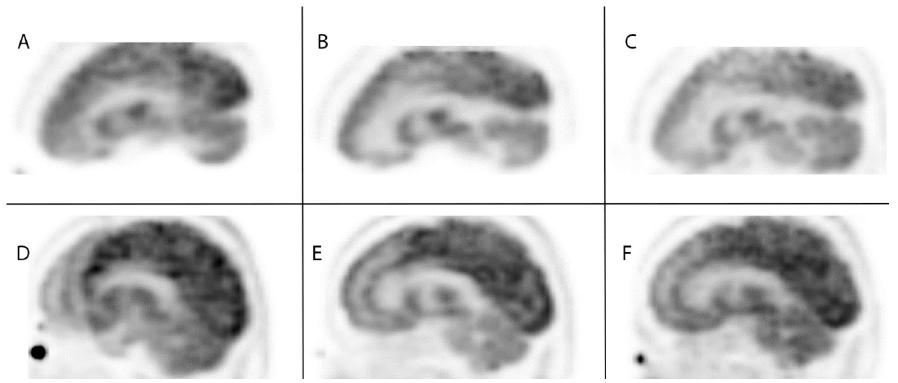
Fig 6. Reconstructed saggital comparisons of uncorrected data, frame-based corrected data, and event-based corrected data. Reconstruction example for Patient Study 3 (Top row) in sagittal plane and Patient Study 5 (Bottom row) in the coronal plane: (A, D) original motion impacted data; (B, E) frame-based correction; (C, F) event-based